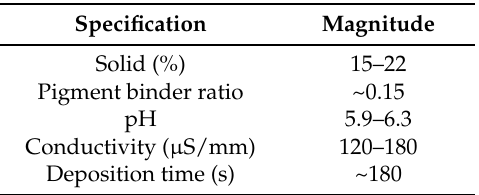
Table 1. Deposition condition of an electro-deposited coating.